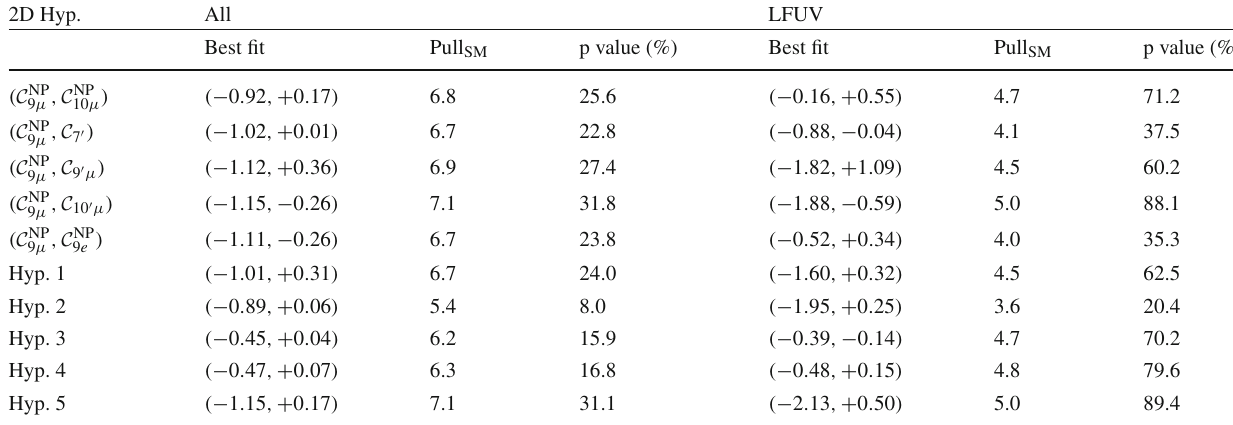
= − C , C NP = C ) , 9 (cid:4) μ 10 (cid:4) μ 9 μ 10 μ